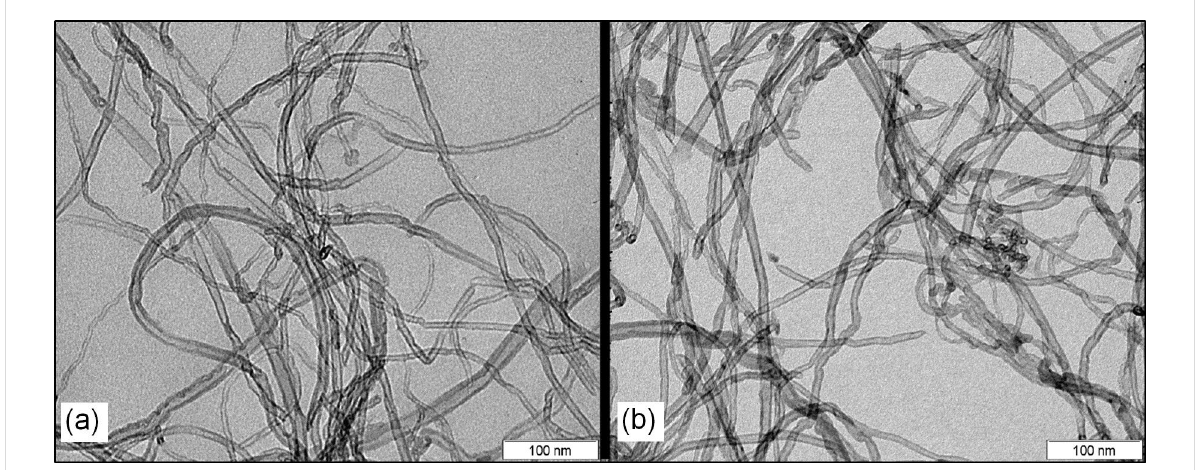
Figure 1: TEM images for COOH–CNTs (a) before acidic treatment and (b) after acidic treatment.